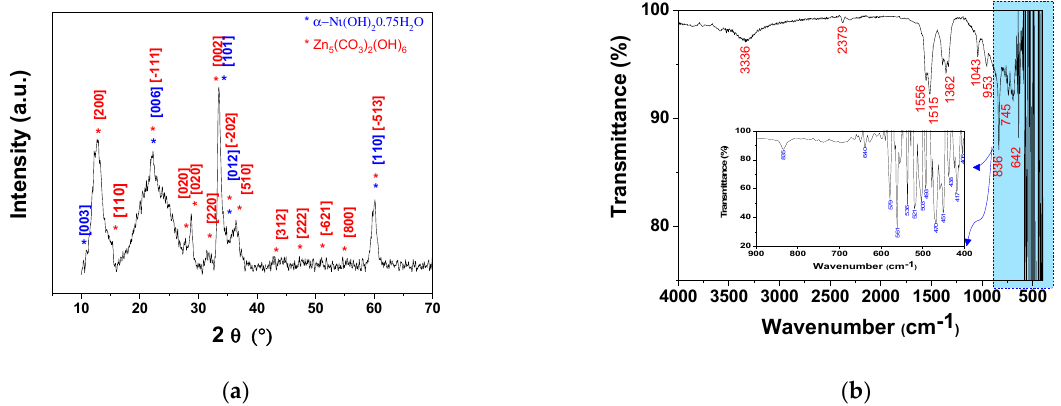
Figure 1. Adsorbent based on Ni/Zn LDH bi-nanostructure nanohybrid synthesized via hydrothermal process at 6h/180°C: XRD diffractogram ( a ) and FTIR spectrum ( b ).